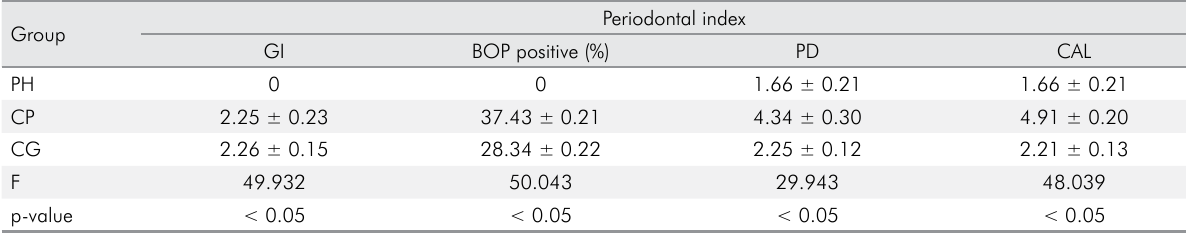
Table 5. Clinical indicators of the study population. Group